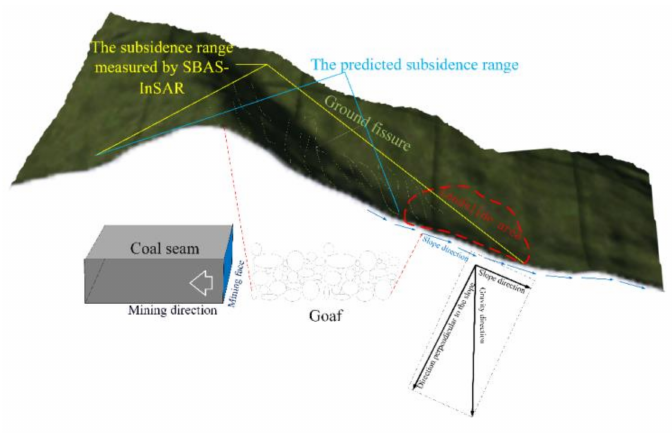
Figure 12. Goaf area and diagram of surface soil stress